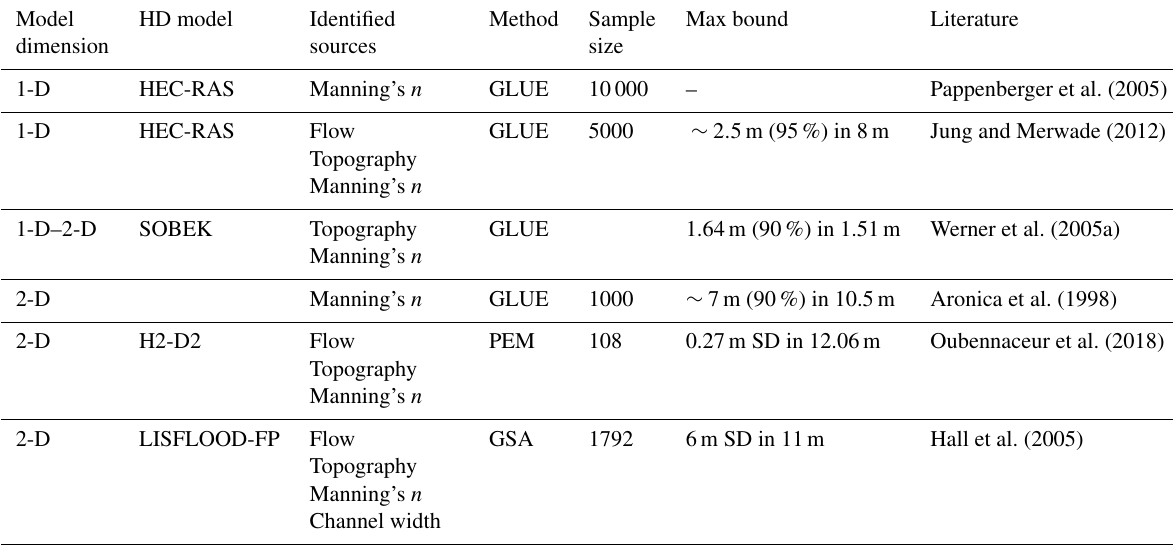
Table 1. A summary of selected publications including the maximum uncertainty bound reported. GLUE, PEM, GSA, and SD stand for generalized likelihood uncertainty estimation, point estimate method, global sensitivity analyses, and standard deviation